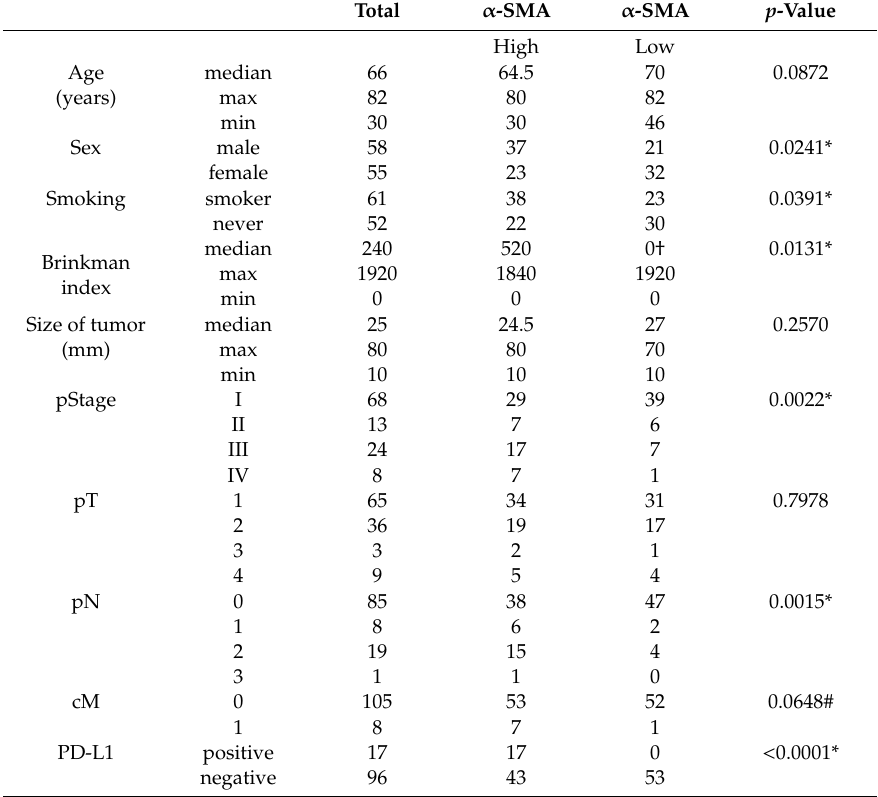
Figure 3. Correlation between overall survival and α -SMA (( a ) Cohort 1, ( c ) Cohort 2) and PD-L1 (( b ) Cohort 1, ( d ) Cohort 2) expression in lung adenocarcinoma cases. Table 2. Association between α -SMA status and clinicopathological parameters in 113 lung adenocarcinoma cases (cohort